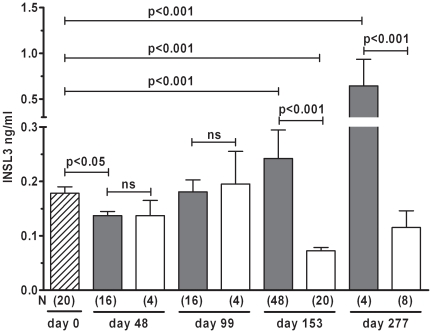
Circulating maternal concentrations of INSL3 in pregnant Brahman and Angus cows (combined since no significant difference between breeds at any time-point).Filled bars represent cows carrying a male fetus, open bars those carrying a female fetus. The cross-hatched bar (left) represents cows at the time-point of insemination. N values are indicated in parentheses below the bars. Statistical significance using both t test and Neumann-Keuls post hoc test are as indicated (ns, not significant).